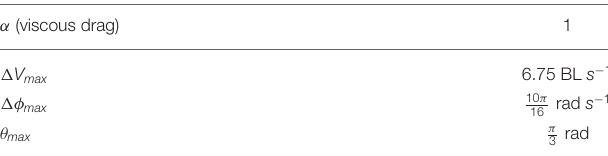
TABLE 1 | Environment parameters described in the